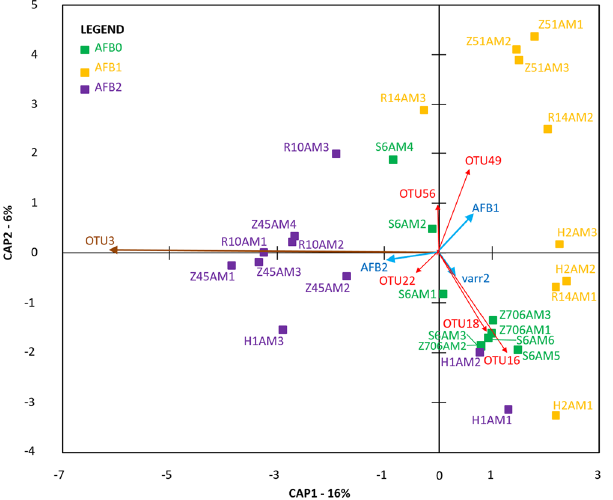
Figure 3. Triplot visualization of principal coordinates in the RDA of the A. mellifera worker microbiome. The analysis was based on the parasitic/environmental microbiome dataset and included varroosis and AFB environmental factors. A correlation triplot containing sample scores given by the weighted sums of OTUs was constructed. The first two axes explained 22% of the total variability in the dataset as indicated by the bracketed